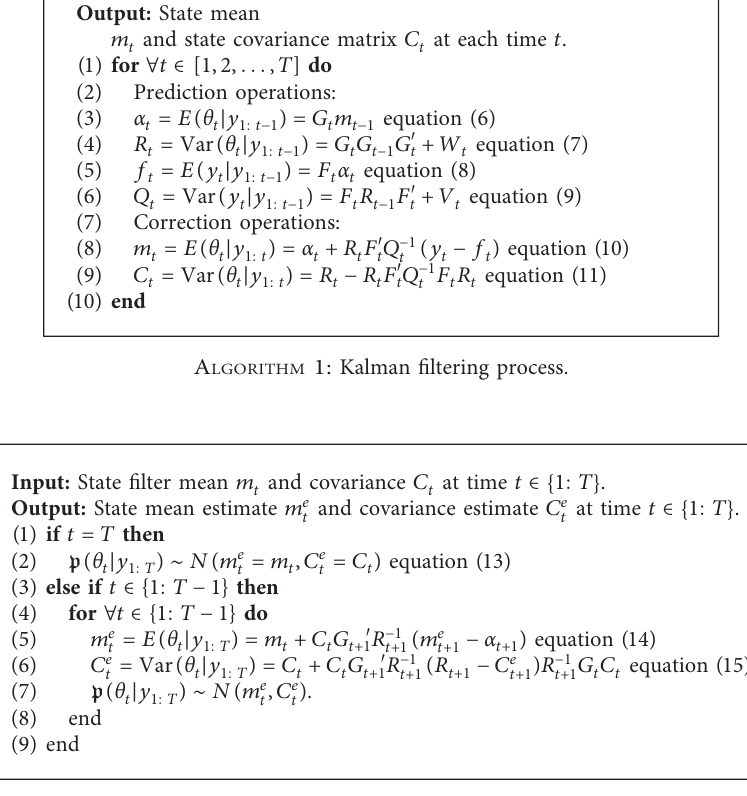
A LGORITHM 2: Kalman forward-backward smoothing